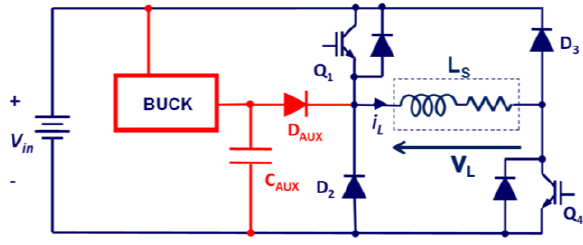
Figure 9. Final design of the power source.